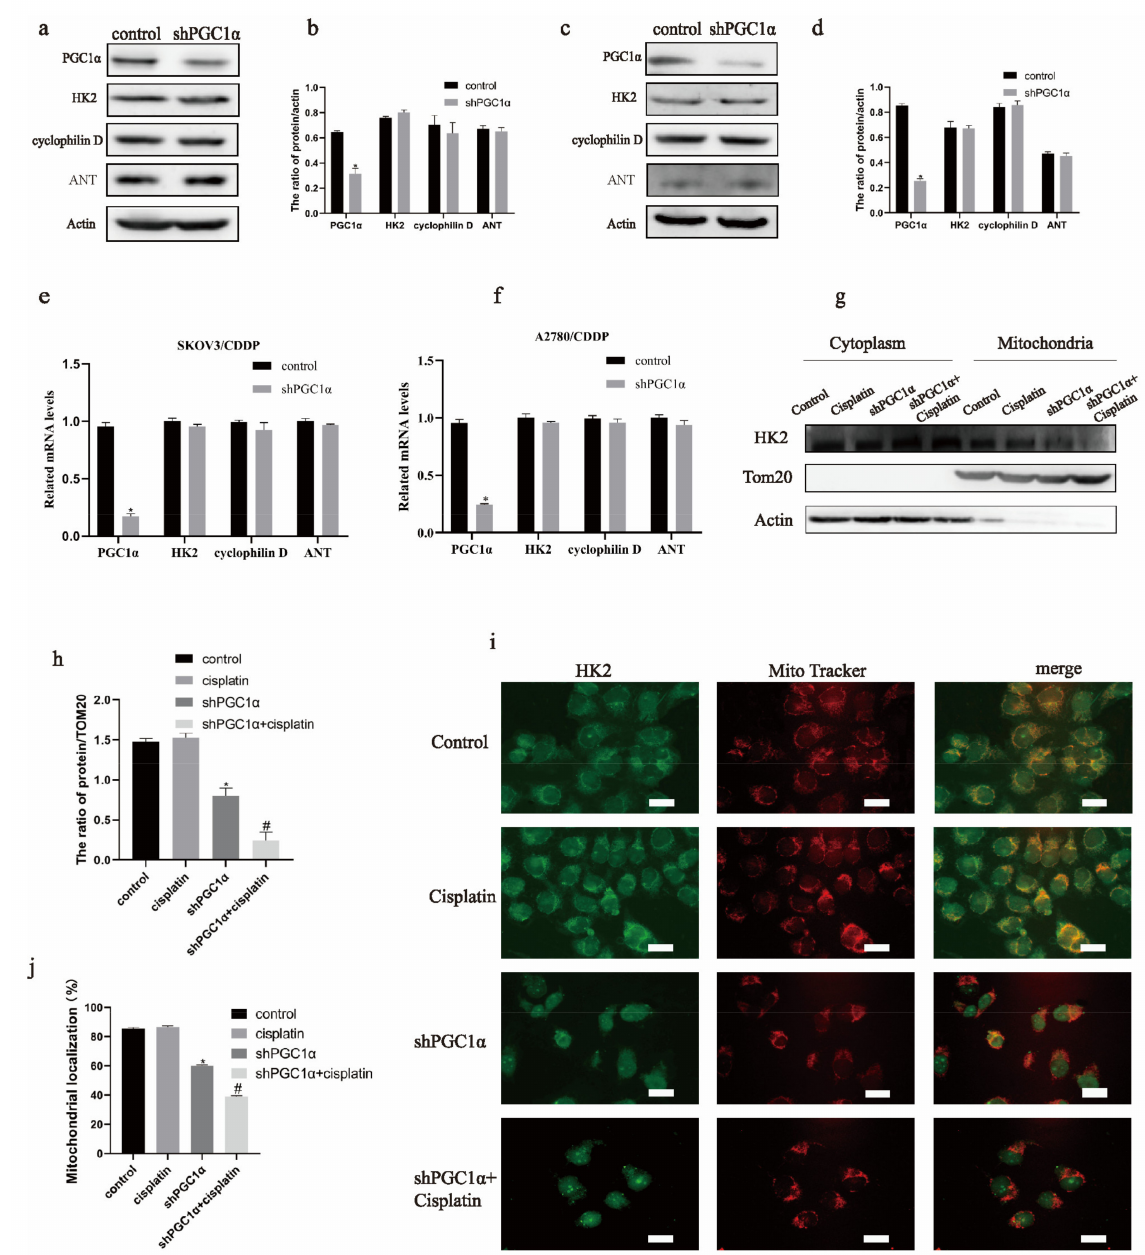
Figure 2. PGC1 α changed the mitochondrial expression of hexokinase 2 (HK2) in ovarian cancer cisplatin-resistant cells. After knockdown PGC1 α , Western blot was used to detect the protein expressions of HK2, cyclophilin D, and adenine nucleotide translocase (ANT) in SKOV3/CDDP and A2780/CDDP cells ( a , c ). The protein/actin ratio is expressed as the mean ± SD; n = 3, * p < 0.05 vs. control ( b , d ). Quantitative real-time PCR (qPCR) detected the mRNA expression of HK2, cyclophilin D, and ANT in SKOV3/CDDP and A2780/CDDP cells ( e , f ), expressed as the mean ± SD; n = 3, * p < 0.05. A mitochondrial extraction kit was used to detect HK2 protein expression in the mitochondria of SKOV3/CDDP cells ( g ). The protein/TOM20 ratio is expressed as the mean ± SD; n = 3, * p < 0.05 vs. control and # p < 0.05 vs. cisplatin ( h ). An immunofluorescence assay was used to detect the localization of HK2 in mitochondria in A2780/CDDP cells ( i ). The percentage of mitochondrial localization was analyzed by ImageJ and expressed as the mean ± SD; n = 3, * p < 0.05 vs. control and # p < 0.05 vs. cisplatin ( j